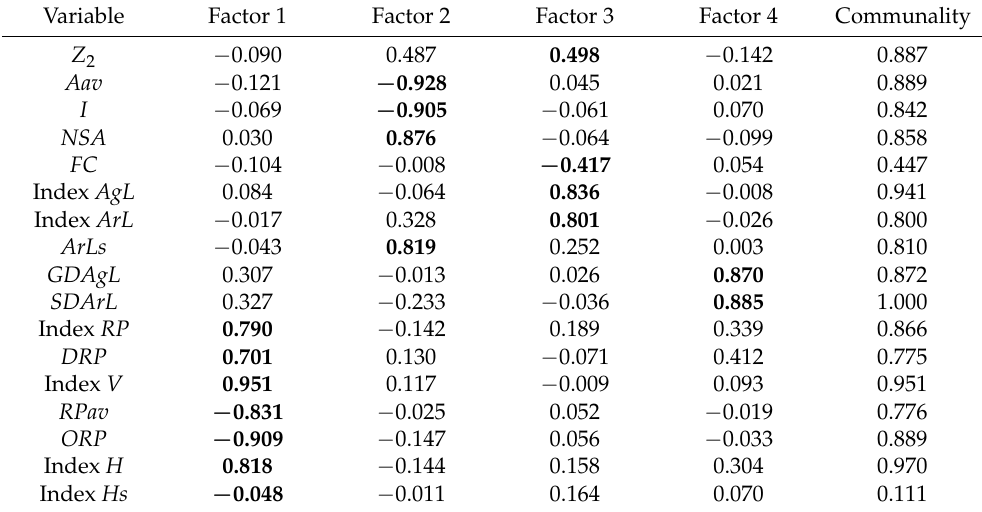
Table 7. Results after varimax rotation (high–high). Rotation method: varimax with Kaiser normal- ization; bold values indicate correlated variables included in the PCs >